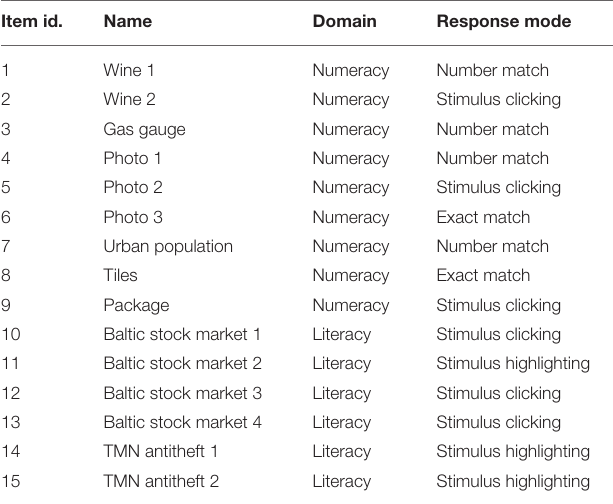
TABLE 8 | Id, name, domain, and response mode of the 15 PIAAC items included in the data analysis of the empirical example. Item